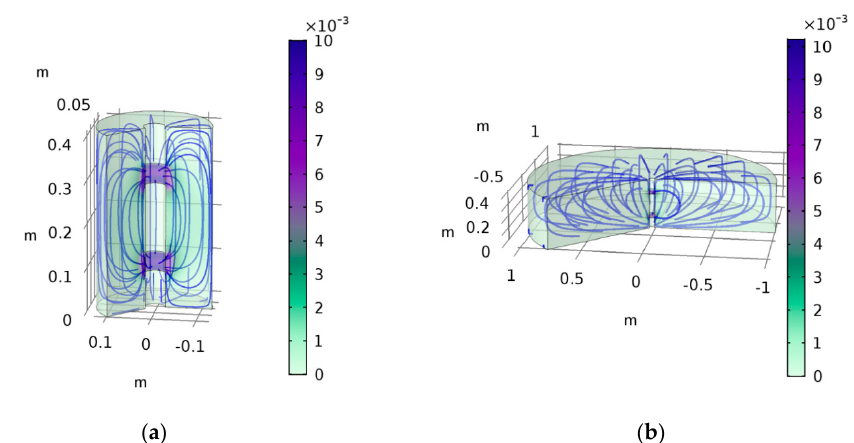
Figure 5. The dipole flow shown by streamlines for two CFD simulations with velocity: ( a ) the simulated physical VCW tank, r = 0.129 m, and ( b ) the large-domain VCW, r = 1.000 m. Color scale is velocity in m/s and the grid is labeled in m. An alternative color scale is also shown in Figures S2 and S3.